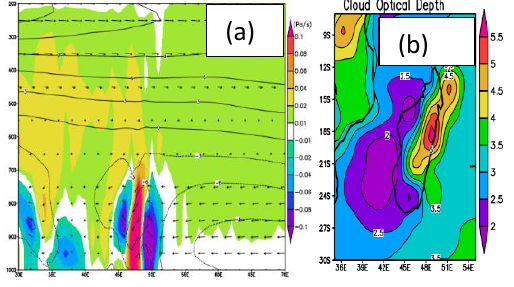
Figure 6. Nine year (2000-2008) average (a) pressure vertical velocity (Pa/s) in shades, zonal velocity (m/s) contour and vectors generated using zonal and vertical velocities during June to September along 18ºS latitude. (b) Cloud optical depth (unit less) averaged during June